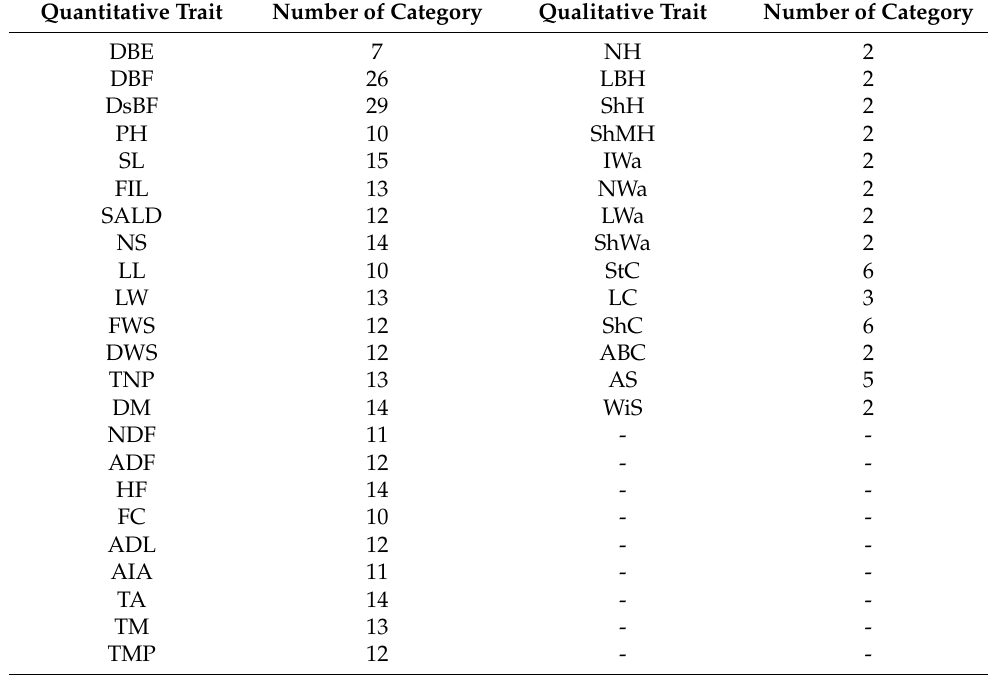
Table 2. The number of Category for each trait. Quantitative Trait Number of Category Qualitative Trait Number of Category